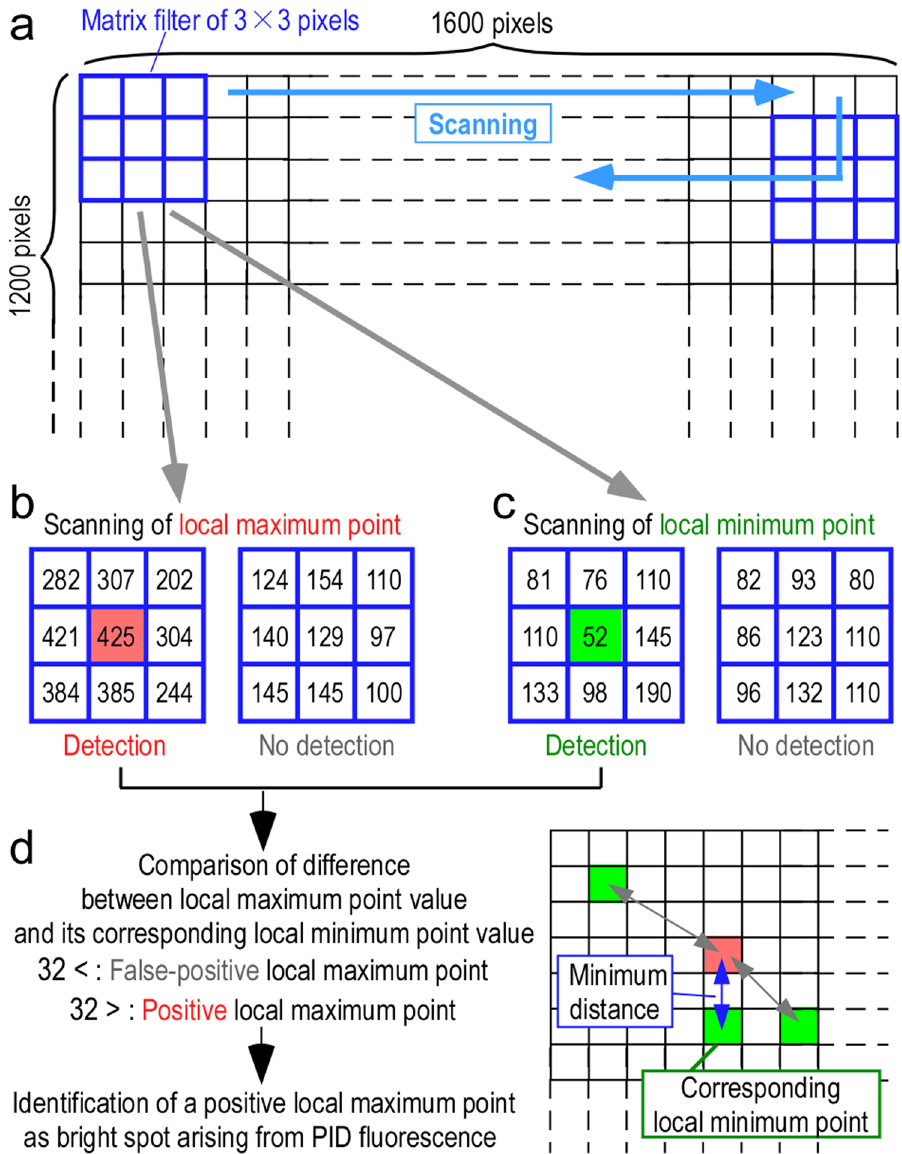
Figure 3. Identification of a positive local maximum point as a bright spot arising from PID fluorescence. All regions of the high-pass-filtered image were scanned using a matrix filter of 3 × 3 pixels to identify local maximum and minimum points ( a ). The local maximum points were identified in cases in which the center pixel value was higher than the 8 surrounding pixel values ( b , red square). Similarly, the local minimum points were identified in cases in which the center pixel value was lower than the 8 surrounding pixel values ( c , green square). In ( b ) and ( c ), the numerical values show the brightness value of each pixel in 12 bits. Therefore, no local maximum points or minimum points were observed when the distribution of the brightness values gradually changed (right panels in b and c ). After all of the local maximum and local minimum points were merged into one image (Fig. 2e), the region around each local maximum point was searched for the nearest local minimum point. This point was called the corresponding local minimum point ( d ). The difference between the brightness of the local maximum point value and its corresponding local minimum point was determined for comparison. If the brightness value difference between the two point values was less than 32 (in the 12-bit image), the local maximum points were ignored as false-positive local maximum points ( d ). In contrast, the local maximum points that had brightness values greater than 32 (in the 12-bit image) were considered positive bright spots that resulted from PIDs ( d